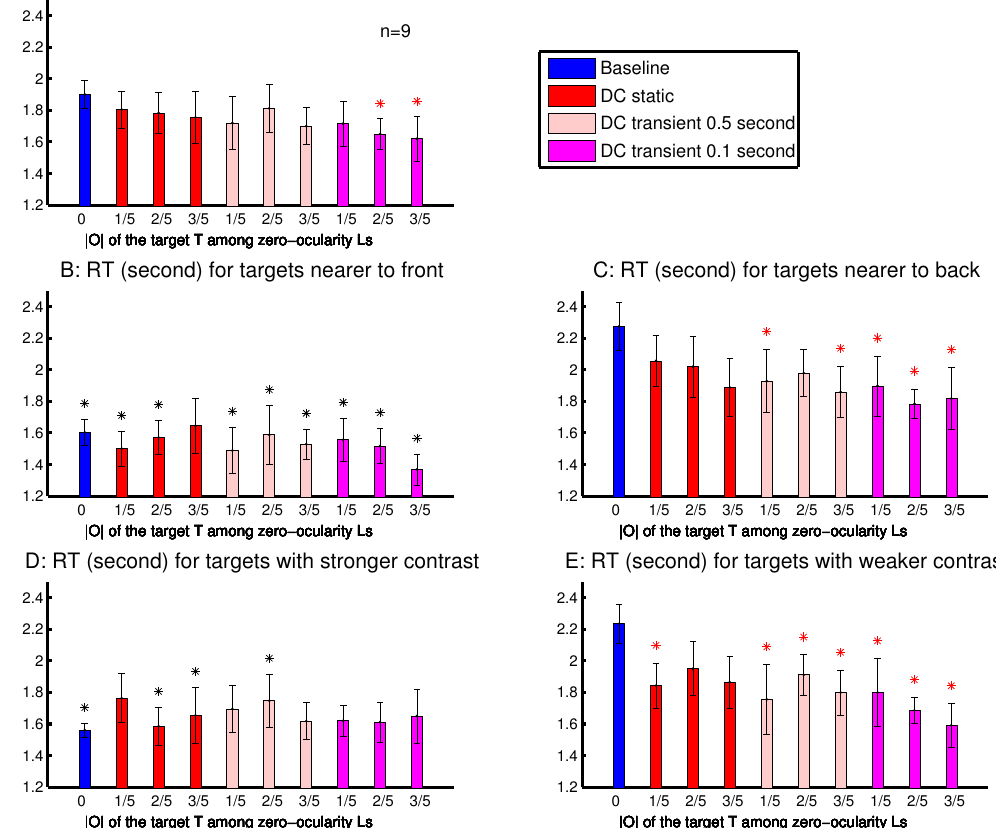
Figure 10. Effects arising from the target’s depth, luminance contrast, ocularity contrast, and the duration of the ocularity contrast in the task to find a target letter ‘T’ among ocularly balanced letter ‘L’s. Manual RT results are averaged across n = 9 observers in sessions interleaving ten conditions, each defined by O the ocularity magnitude of the target ‘T’ and by whether and how transient this | | non-zero). Each input letter had a random depth (with a random disparity value within ( except for the zero-disparity items in the left most and right most columns of the search array) and a random (binocular summation of) luminance contrast C L + C R . ( A ) RT for each target’s averaged across observers regardless of the target’s depth and luminance contrast. ( B , C ) as in (A), except that each is only for trials with the near-targets (B) or the far-targets (C). ( D , E ) as in (A), except that each is only for trials with the targets having a stronger (D) or weaker (E) luminance contrast C L + C R . In each plot, a red ‘*’ above a data point from a DC condition (with target’s was significantly different from the RT of the baseline condition (with target’s O = 0) in the same plot. In (B) or (D), respectively, a black ‘*’ above each RT data point indicates a significant depth effect (B) or luminance contrast effect (D), when this RT was significantly different from the corresponding RT (in the condition having the same magnitude and temporal characters for the target’s observers had normal depth vision, and one was not naive to the purpose of the